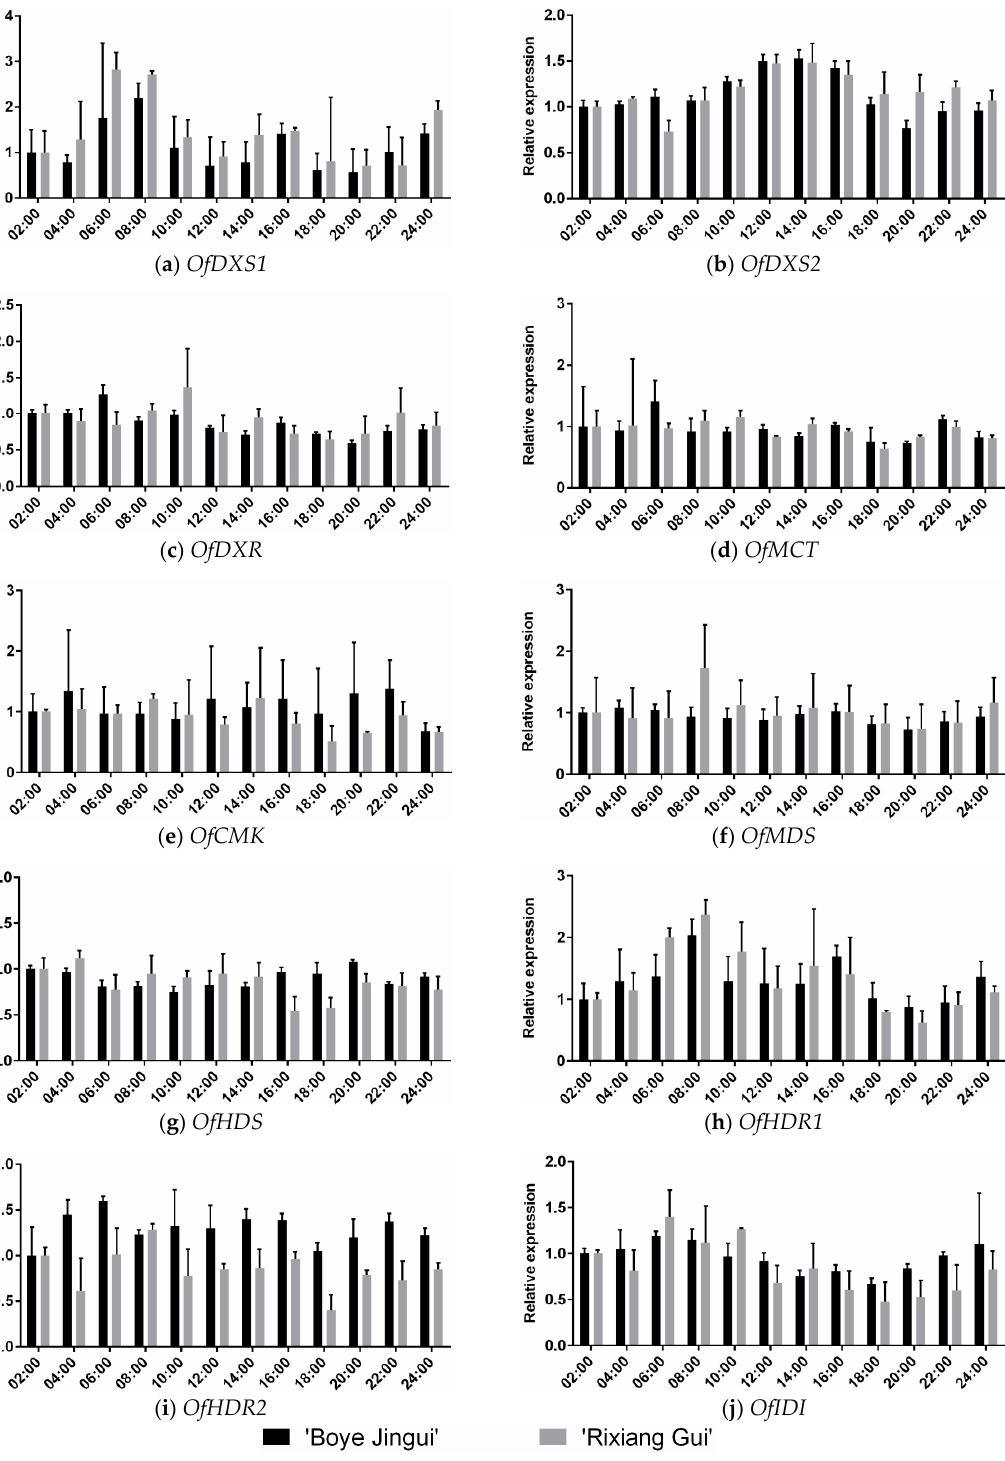
Figure 5. Expression patterns of MEP pathway genes during diel oscillations of Osmanthus fragrans . These cDNA templates were isolated from 02:00 a.m. to 24:00 p.m. with two-hour intervals in full blooming stage. Data were presented as means with error bars indicating standard deviation.